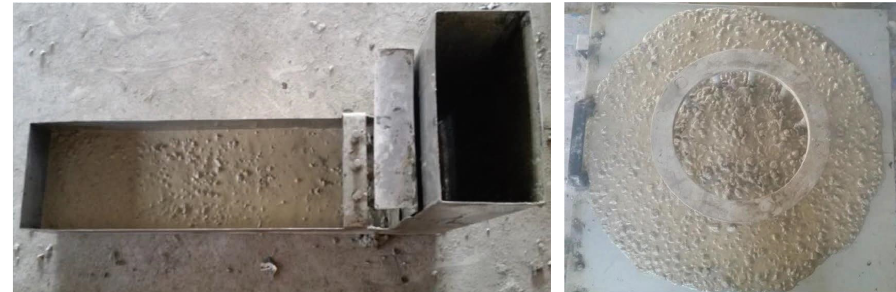
Figure 3: L-box test and J-ring